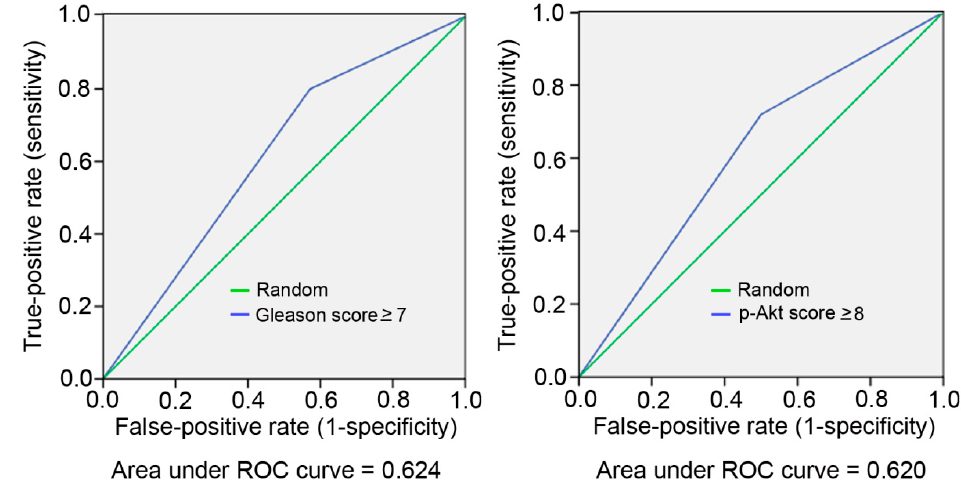
Figure 3. Sensitivity and specificity of gain of a high Gleason score or high p-Akt in specimens with respect to biochemical recurrence (BRC). Areas under the ROC (AUC) for high p-Akt image score ( ≥ 8) and high Gleason score ( ≥ 7) were 0.62 and 0.624, indicating similar discriminatory abilities for